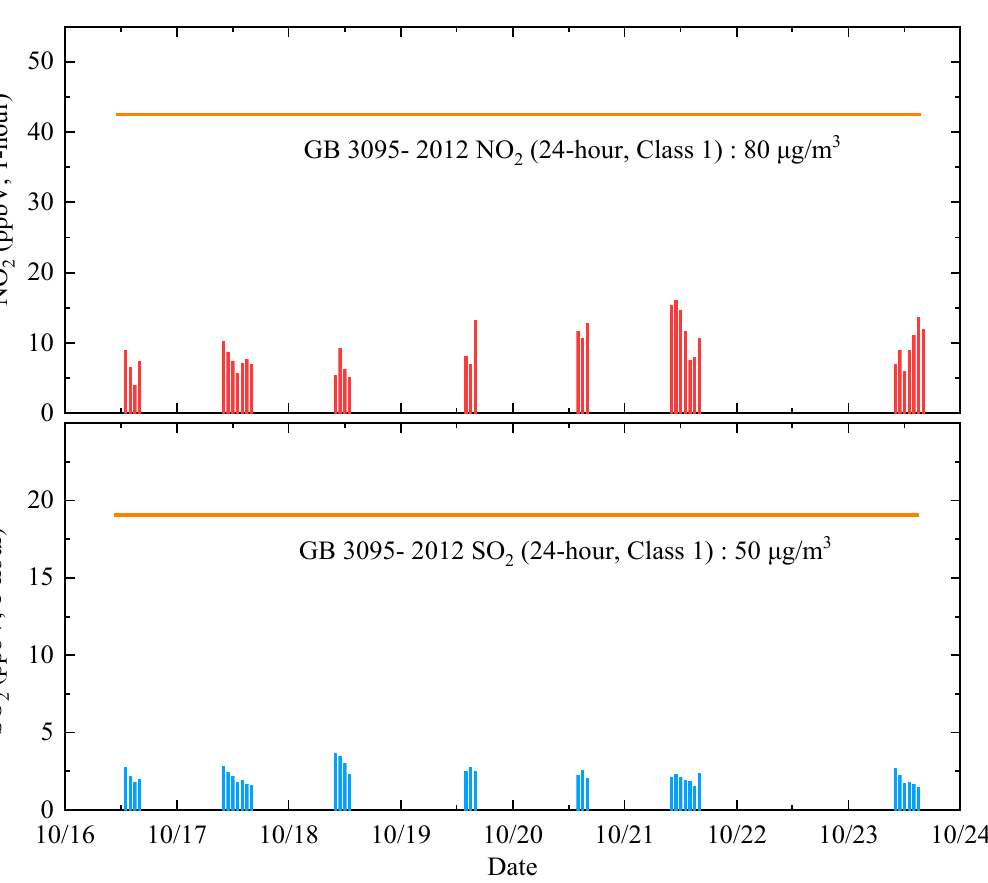
Figure 6. One-hour mean concentrations of NO 2 and SO 2 measured by LP-DOAS instrument. Table 1. Results for the Boeing 737–800 aircraft.